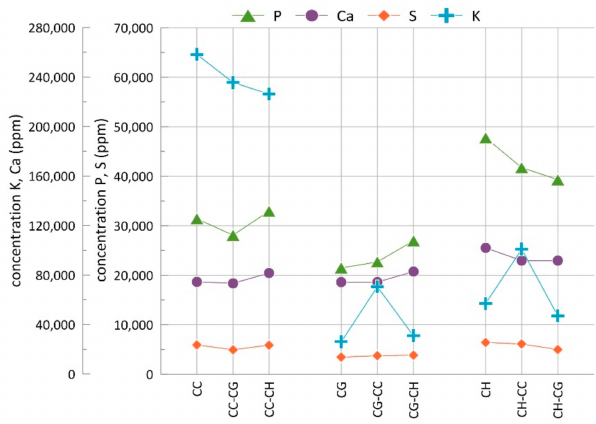
Figure 2. Distribution of macroelements in the ashes of the examined raw